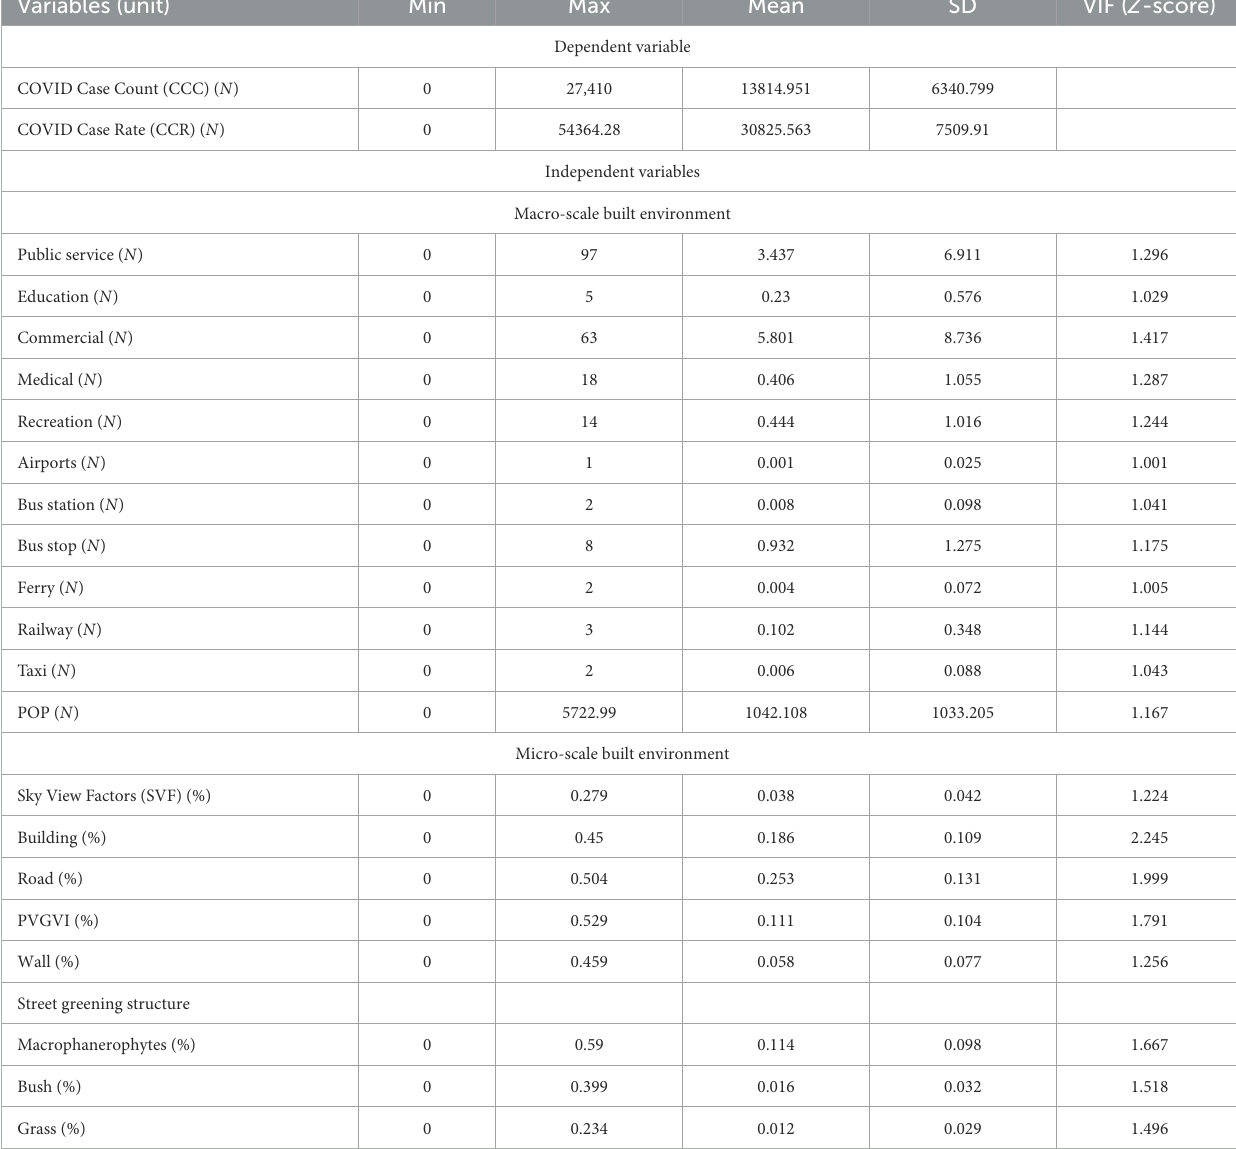
TABLE 2 Summary statistics of all variables in Manhattan, New York, United States ( n =